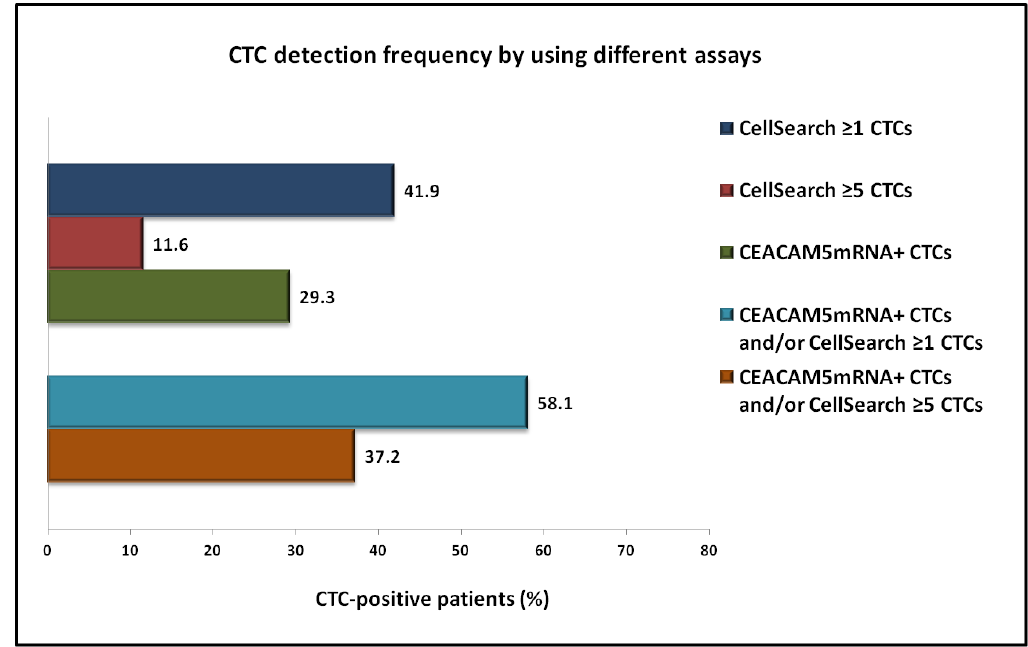
Figure 1. Frequency of CTC detection in patients with NSCLC at baseline of first-line chemotherapy, by using the CellSearch or the CEACAM5 mRNA assay, or their combination. Table 2. CTC status of patients using different detection assays (no. of patients: n = 41).